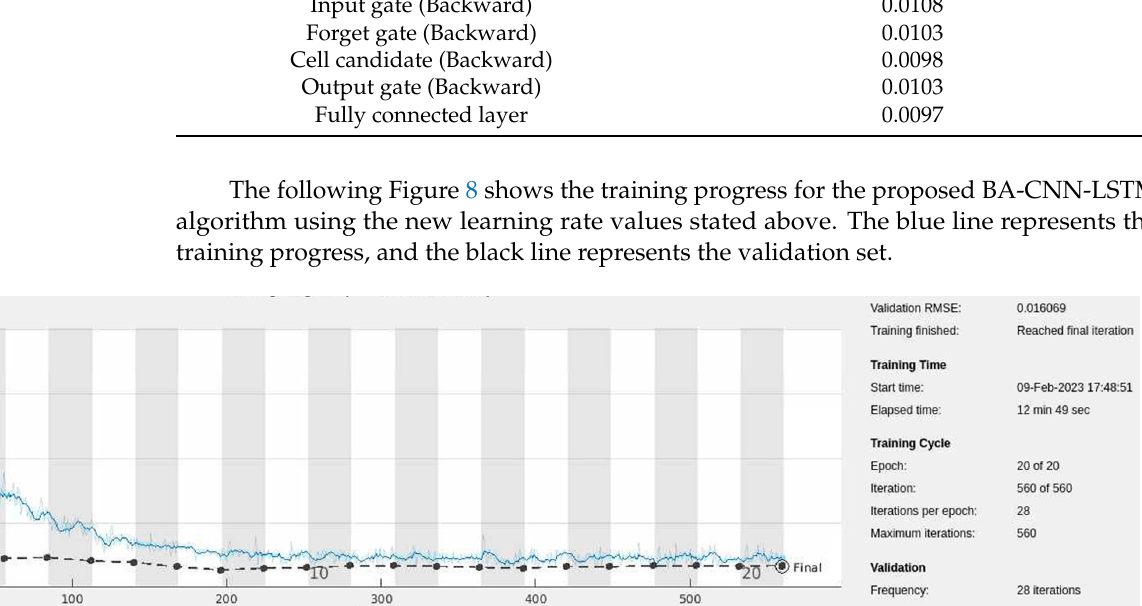
Table 5. The average error for percent of porosity (artificial porosity